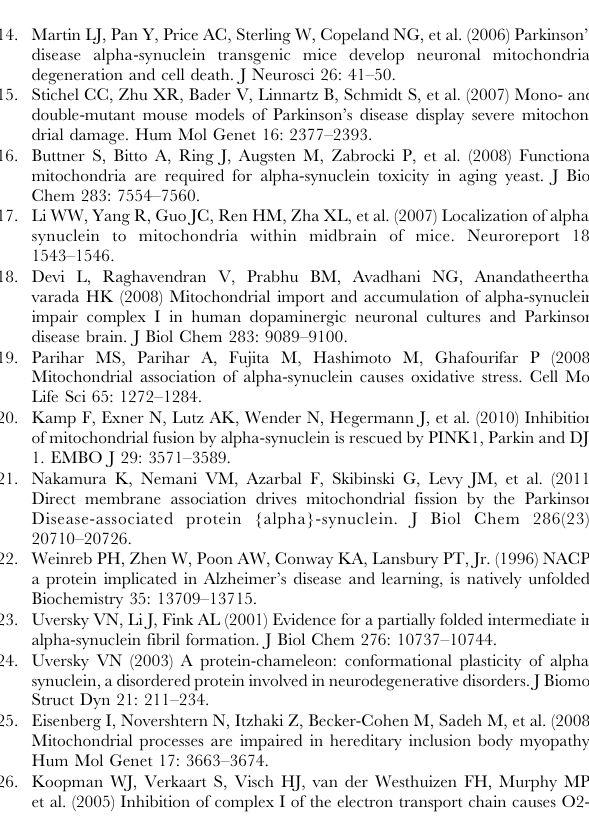
Figure S2 Mitochondrial preparation confirmation.